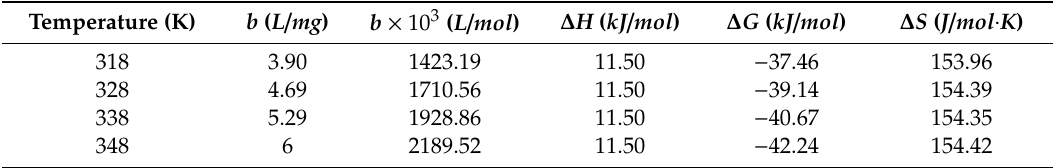
Table 4. Fitting results of organic sepiolite adsorption thermodynamic function.